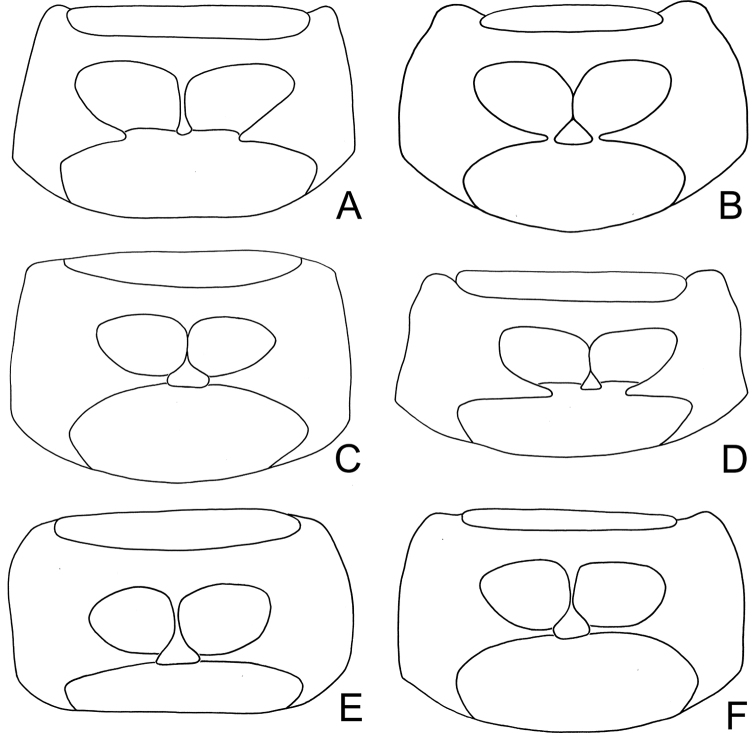
Prothorax, ventral view AAtrachya
menetriesiiBChinochya
unifasciataCMonolepta
gracilipesDNeochya
nitidissimaEPaleosepharia
formosanaFTsouchya
mediofasciata.